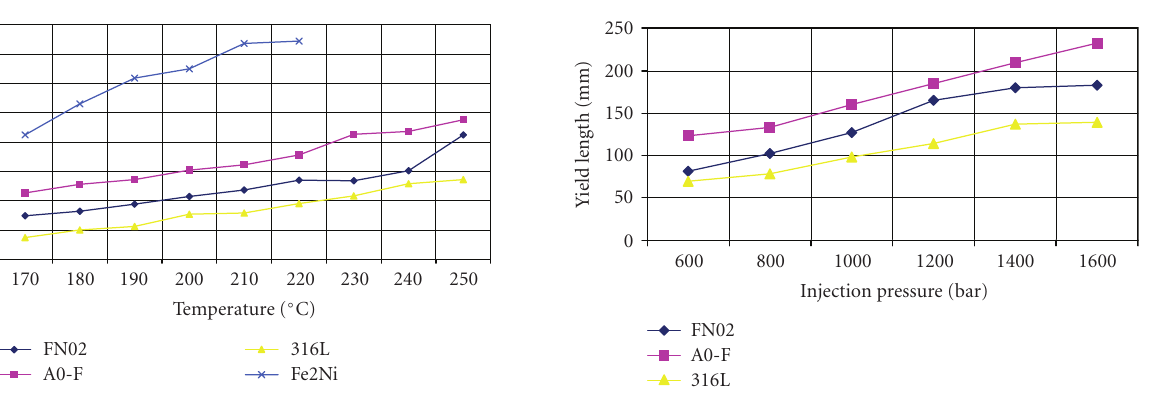
Figure 9: Yield length versus temperature graph for feedstocks.